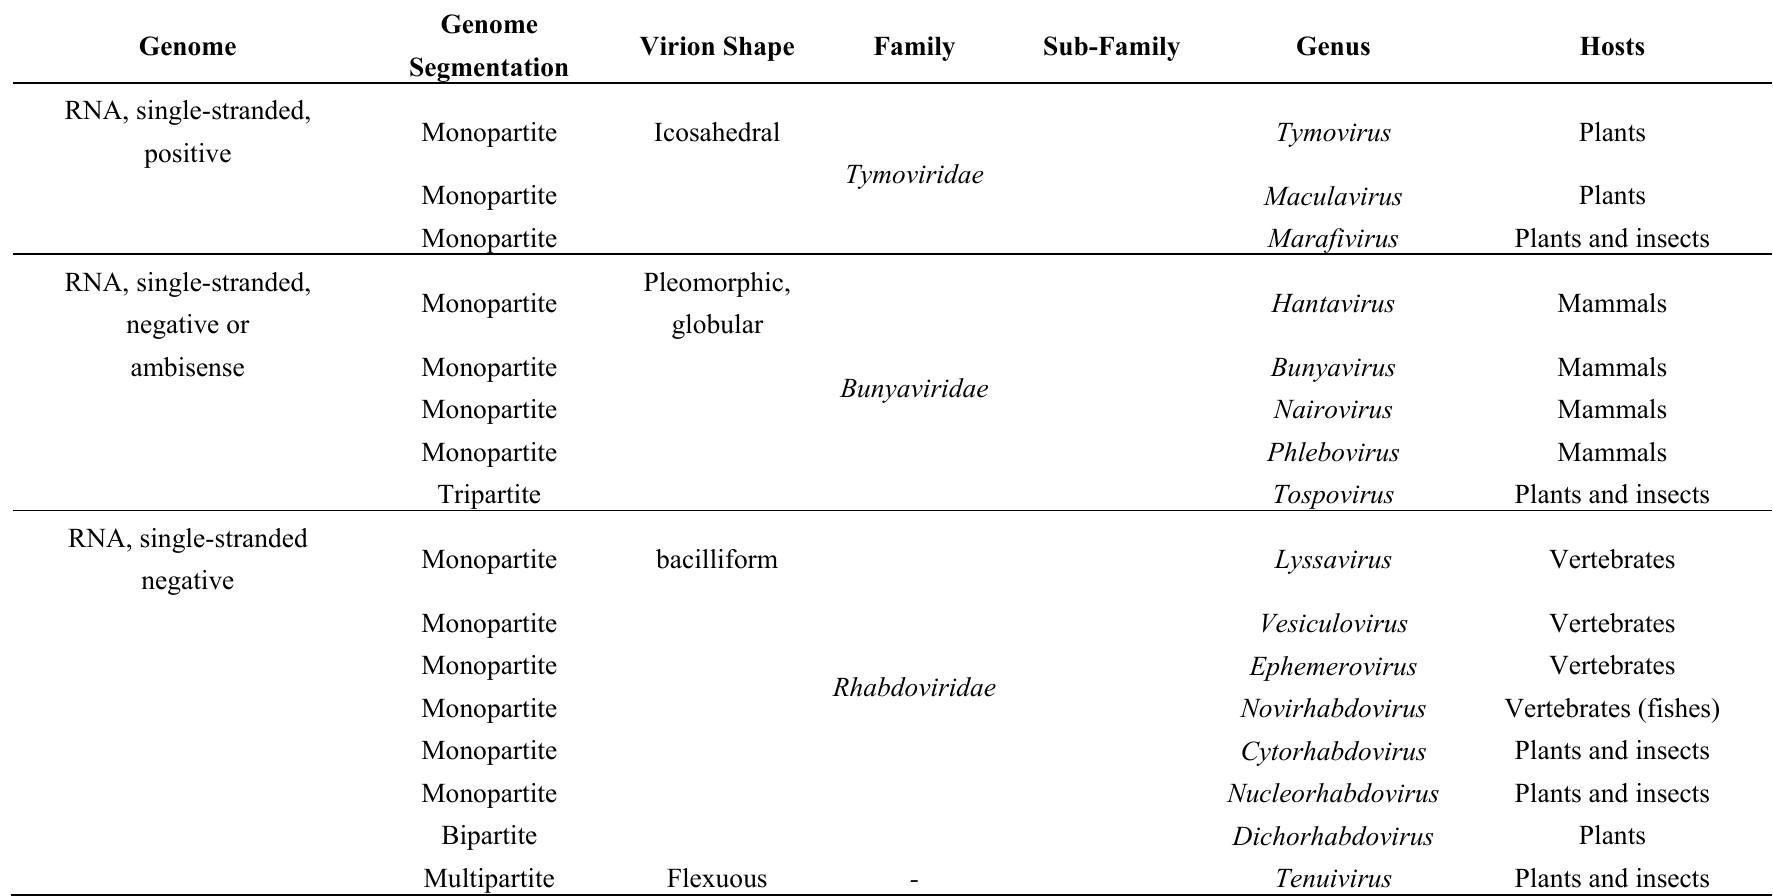
Table 1. Virus families composed of plant and humans or non-human animal